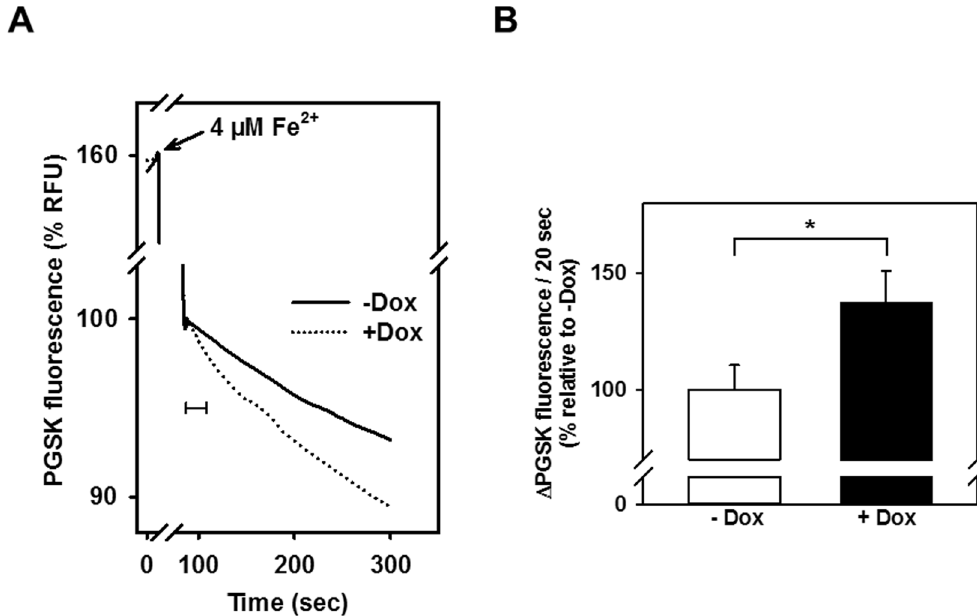
Figure 1. Mitochondrial Fe 2 + uptake is increased after doxycycline induction of rDMT1 in HEK293 cells. Mitochondria were isolated from uninduced ( − Dox.) or 48 h with 25 nM doxycycline induced ( + Dox.) rDMT1-HEK293 cells, loaded with PGSK, and subsequently washed as indicated in Materials and Methods. After 10 min of pre-incubation at pH 7.0, PGSK fluorescence was measured at λ ex = 506 nm and λ em = 532 nm. ( A ) Representative traces of the time course of the fluorescence after the addition of 4 µ M Fe 2 + . Curves are normalized to fluorescence at the beginning of the second phase (100%). ( B ) Statistical analysis of second phase PGSK quenching. Initial slopes of quenching, as indicated by the 20s-scale bar in A, were normalized to measurements in mitochondria isolated from uninduced cells. Means ± SEM of 26 measurements in 10 independent experiments are shown. * P < 0.05. RFU, relative fluorescence